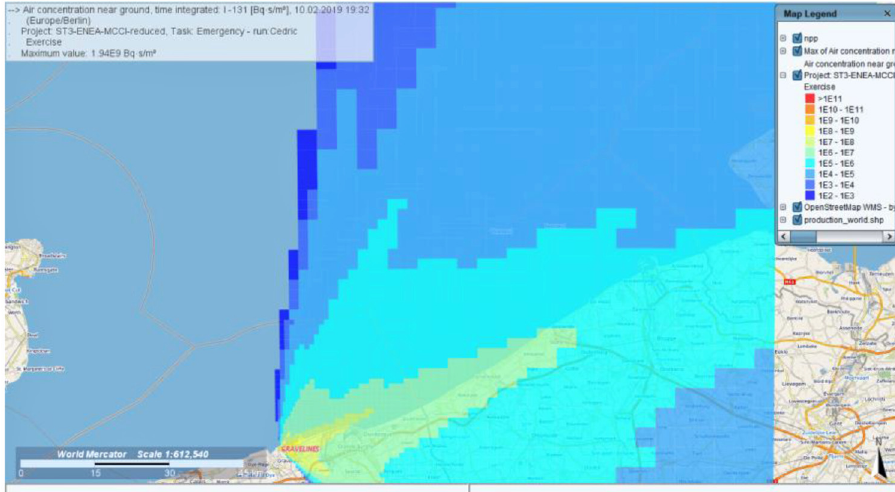
Fig. 5. Example of JRODOS dispersion calculation results from